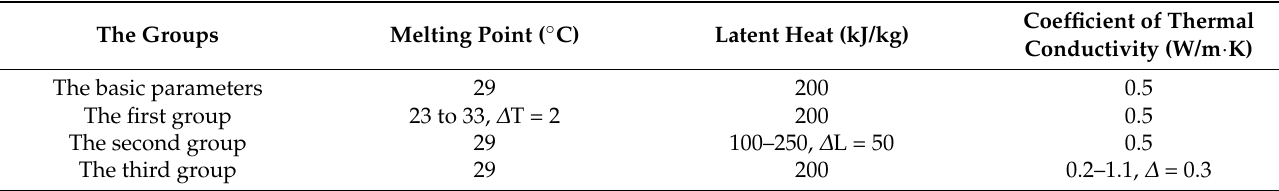
Table 3. Physical properties of different PCMs.